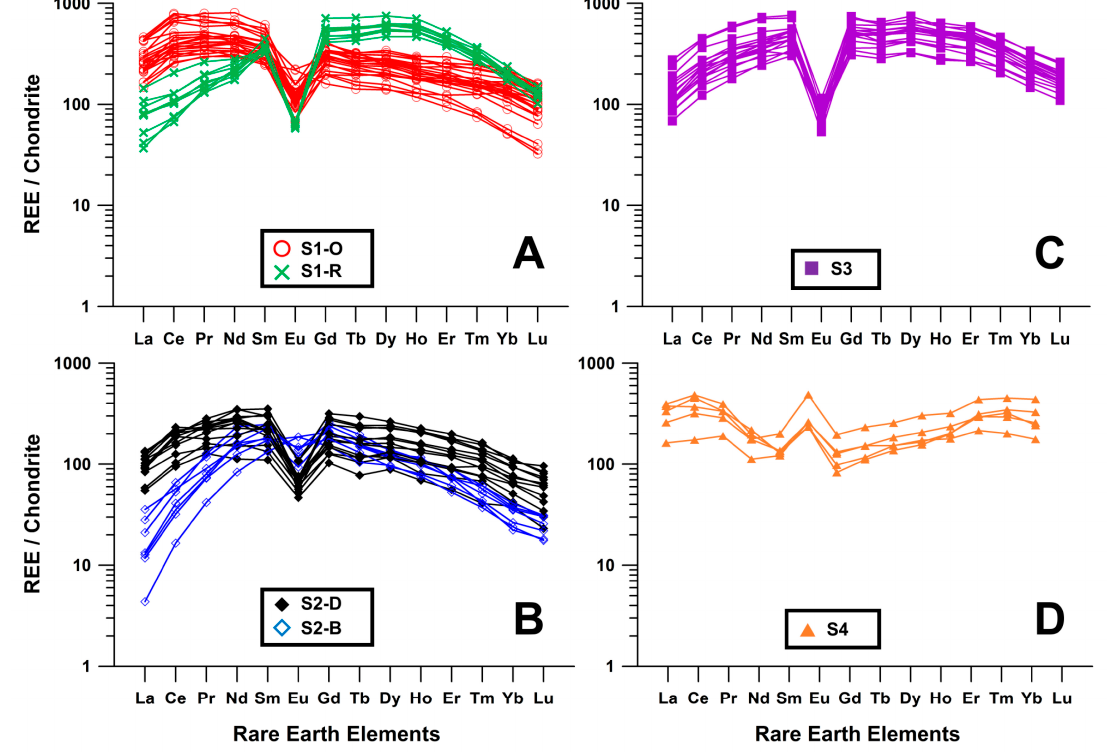
Figure 5. Chondrite normalized rare earth element (REE) profile of scheelite (chondrite data based on Taylor and McClennan (1985)). ( A ) Oscillatory zoned part of stage I scheelite (S1-O) shows positively inclined light REE (LREE)-enriched pattern with negative Eu anomaly. Rim area of stage I scheelite (S1-R) shows LREE-depleted and middle REE (MREE)-enriched pattern with negative Eu anomaly. ( B ) Dark CL area of stage II scheelite (S2-D) shows MREE-enriched pattern with negative Eu anomaly. Bright CL area of stage II scheelite (S2-B) shows LREE-depleted and MREE-enriched pattern with slightly negative or no Eu anomaly. ( C ) Stage III scheelite shows MREE-enriched M-type tetrad pattern with negative Eu anomaly. ( D ) Stage IV scheelite shows MREE-depleted pattern with W-type tetrad pattern with positive Eu anomaly.